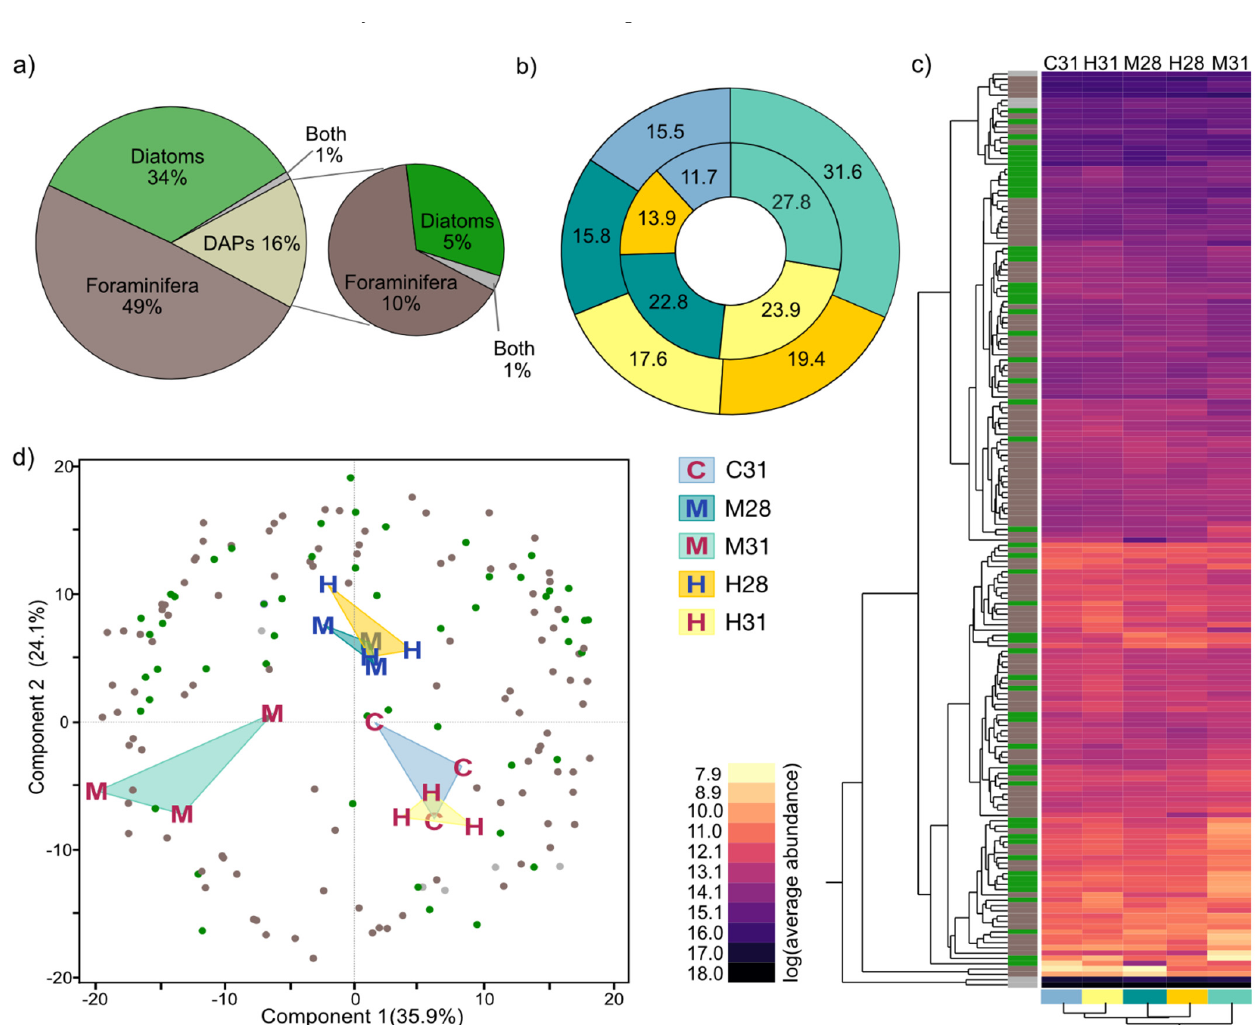
Figure 5. Summary of the proteomic results: ( a ) proportion of all identified proteins (n = 1103) and differentially abundant proteins (DAPs, n = 173) in Amphistegina lobifera holobionts that were assigned to the foraminiferal host, their photosymbiotic diatoms, or both; ( b ) proportion of DAPs per treatment of elevated p CO 2 (C = 492 ppm, M = 963 ppm, H = 3182 ppm) at 28 °C or 31 °C in the host (outer) and the photosymbionts (inner); ( c ) hierarchical cluster analyses based on average linkage and heatmap where rows represent DAPs and columns represent the log-transformed average of three replicates per treatments, and the left column indicates if the protein was associated with the host (brown), photosymbionts (green), or both (grey); ( d ) principal component analysis biplot on correlation of all DAPs, with letters connected by triangles indicating the replicate samples of each treatment combination of different p CO 2 at control (blue) or high (red) temperature, and dots indicating the DAPs (colors as in ( c )) as loading variables.